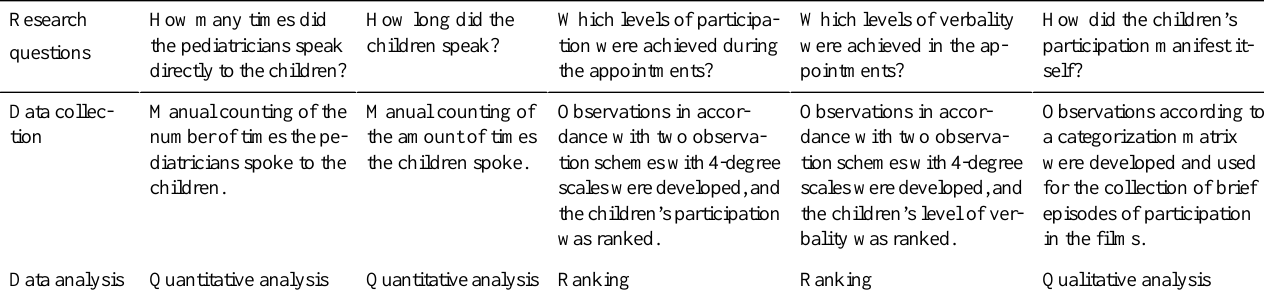
Table 2. Summary of the research questions, data collection methods, and data